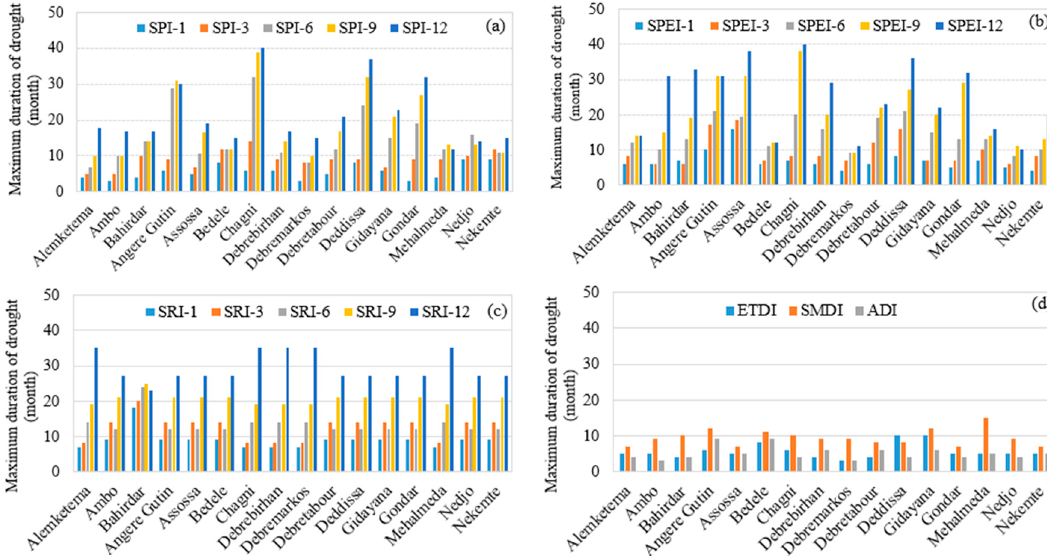
Figure 5. The maximum duration of consecutive drought indicated by SPI ( a ), SPEI ( b ), SRI ( c ) and other indices ( d ) such as ETDI, SMDI, and ADI. Five temporal scales (i.e., 1-, 3-, 6-, 9-, and 12-months) were considered for SPI, SPEI, and SRI.